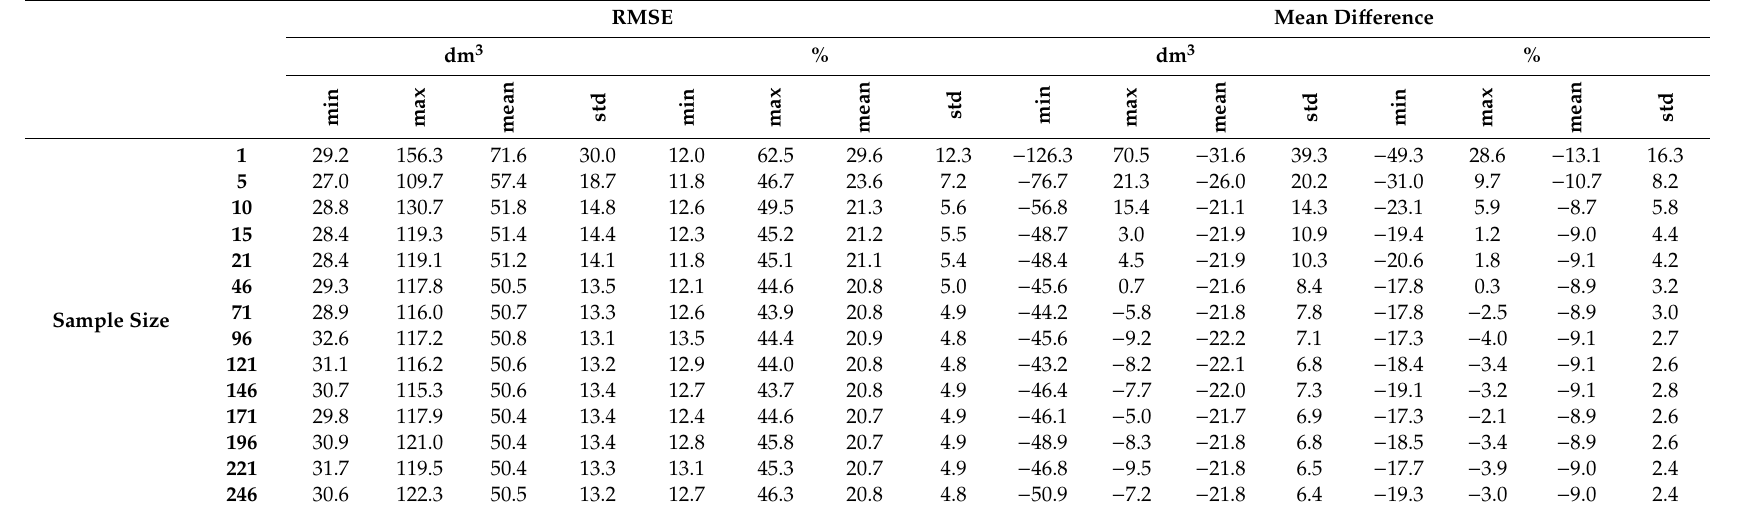
Table 2. Absolute and relative root mean square error (RMSE) and mean di ff erence of volume estimates based on parametrized taper curves obtained with samples of varying sizes that were randomly selected 100 times. Min = minimum, Max = maximum, Mean = average, Std = standard